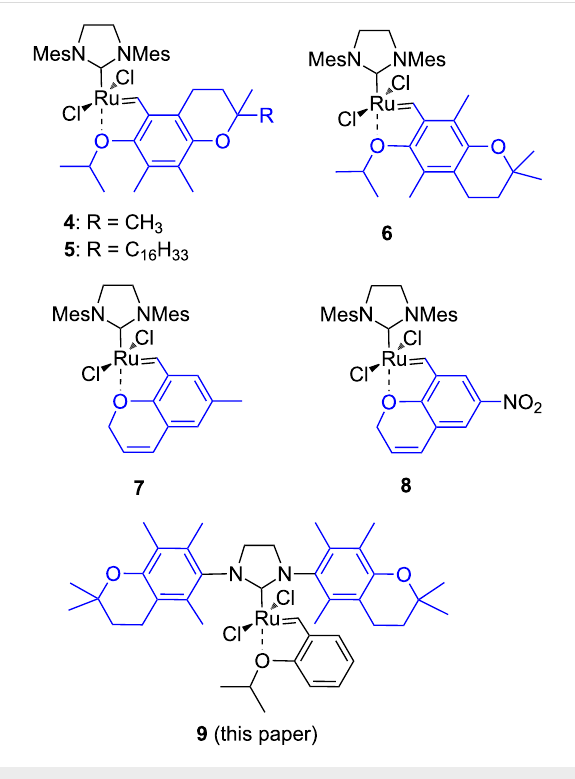
Figure 2: Selected ruthenium metathesis catalyst bearing chromanyl